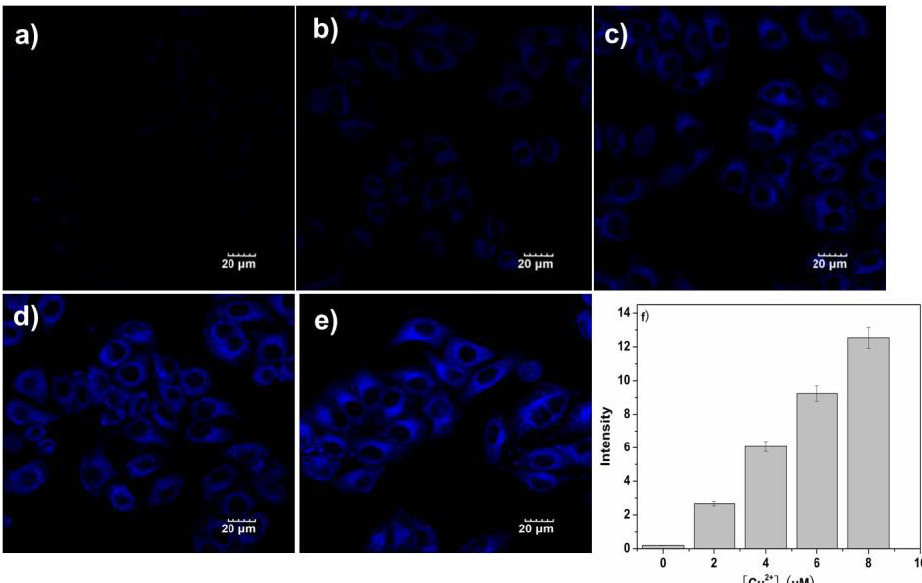
min; e ) image of bright field cells in panel d ); f ) images of overlay in panels d , e ). 30 min; ( e ) image of bright field cells in panel ( d ); ( f ) images of overlay in panels ( d , e ). to intracellular Cu 2+ level changes in living cells.